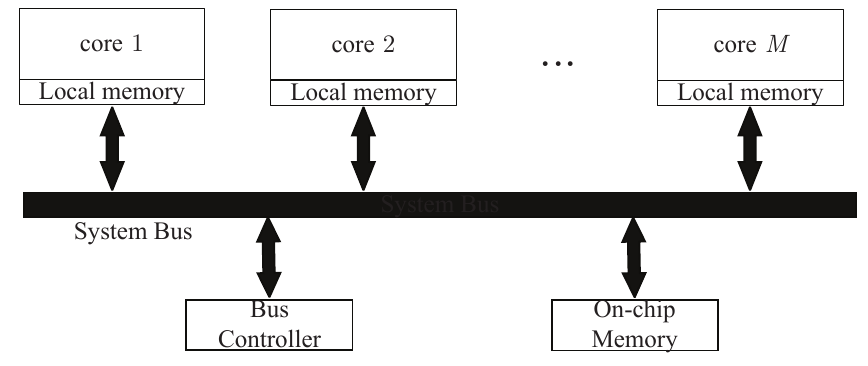
Figure 1. System